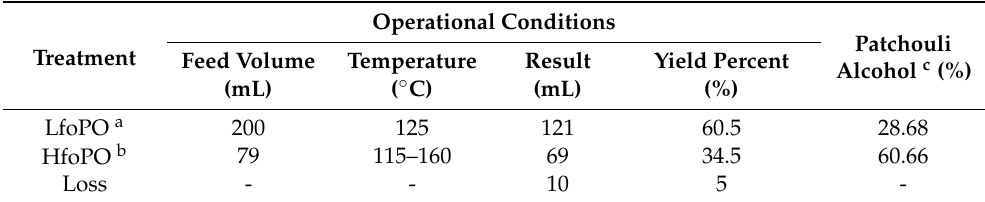
Table 4. The percent yield of the light fraction and the heavy fraction of patchouli oil was produced using the molecular fractionation